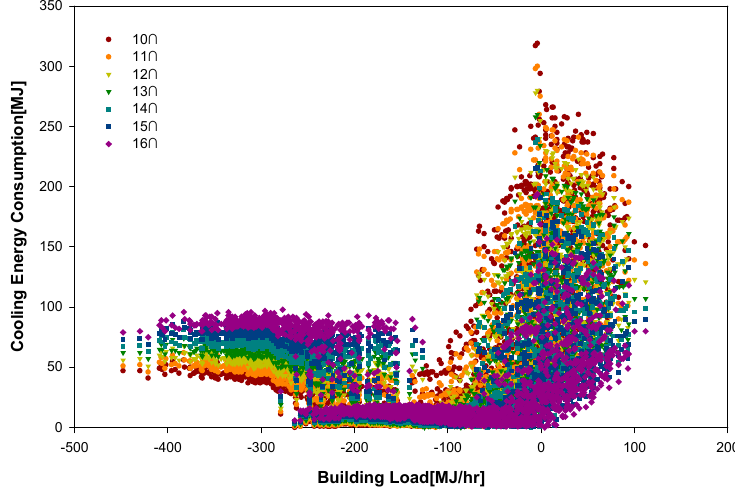
Energies 2018 , 11 , x FOR PEER REVIEW Figure 9. Energy Consumption for indoor load based on the supply air temperature.